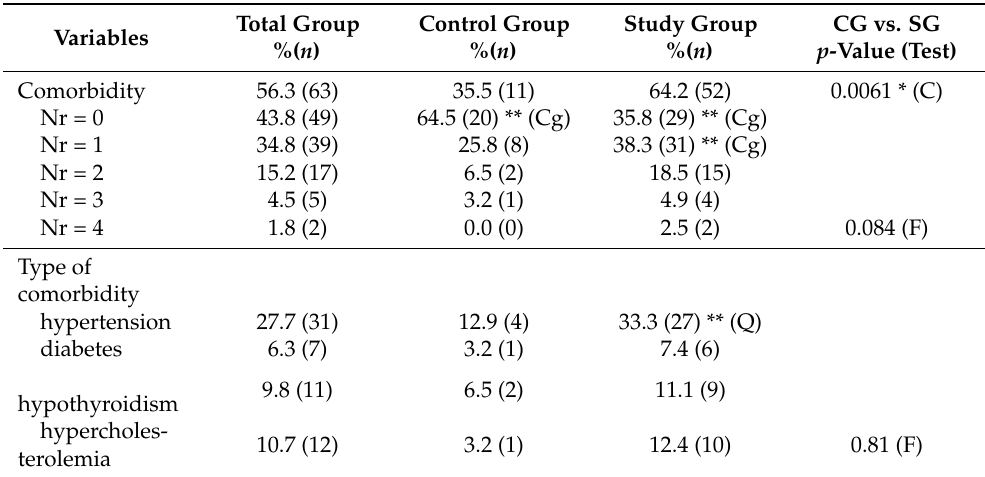
Table 3. The comorbidities in the study group and control